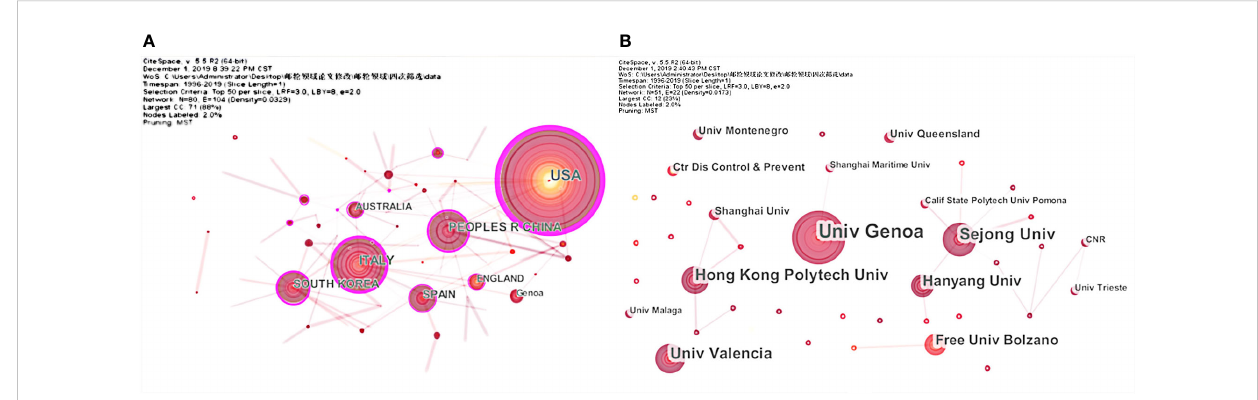
FIGURE 2 A visual map of countries/organizations in the cruise research: (A) the main countries in the cruise research; (B) the organizations in the cruise research.